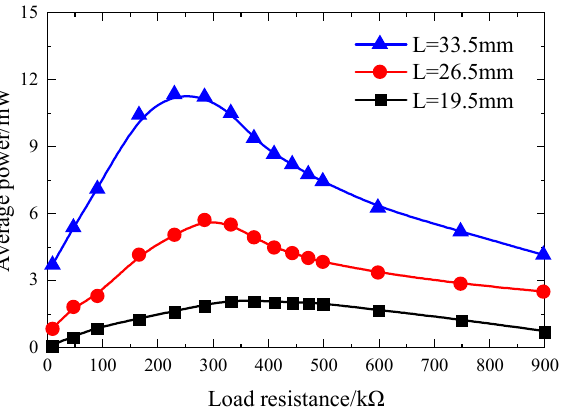
Figure 9. Average powers from PZT4 patch of 1#1 on unimorph PCS of 1# piezoelectric brick versus the load resistance and the force arm length ( F = 500 N, f = 1 Hz). ( it is modified)